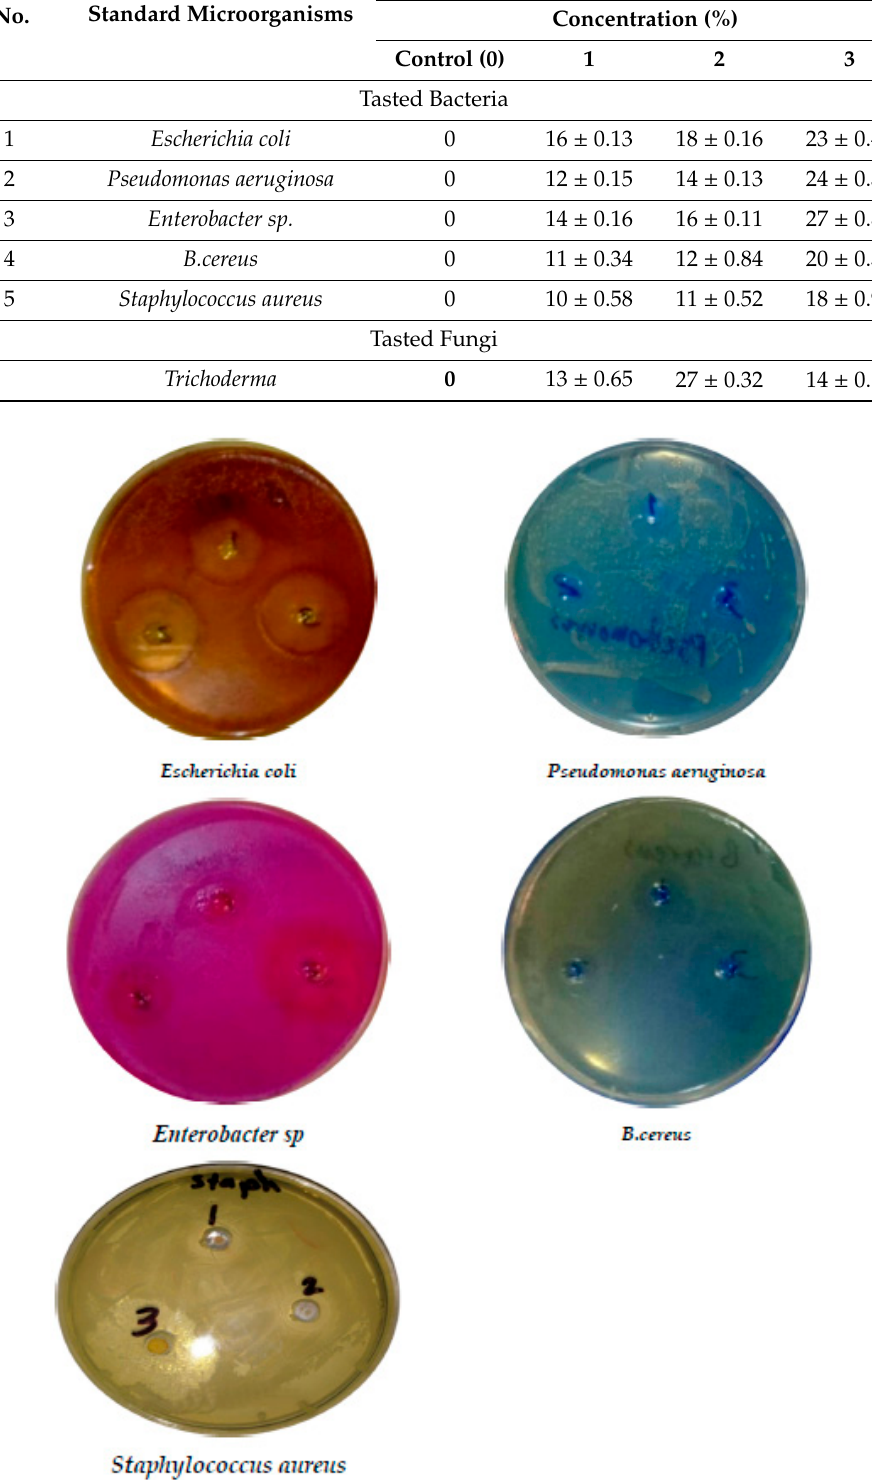
Table 4. Antimicrobial activity of the MS edible film incorporated with CEO.